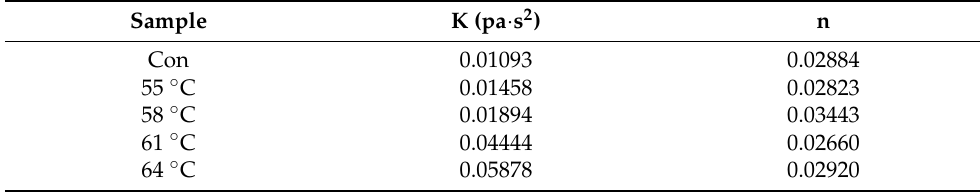
Table 1. The effect of different heating treatment conditions on the static rheological parameters of